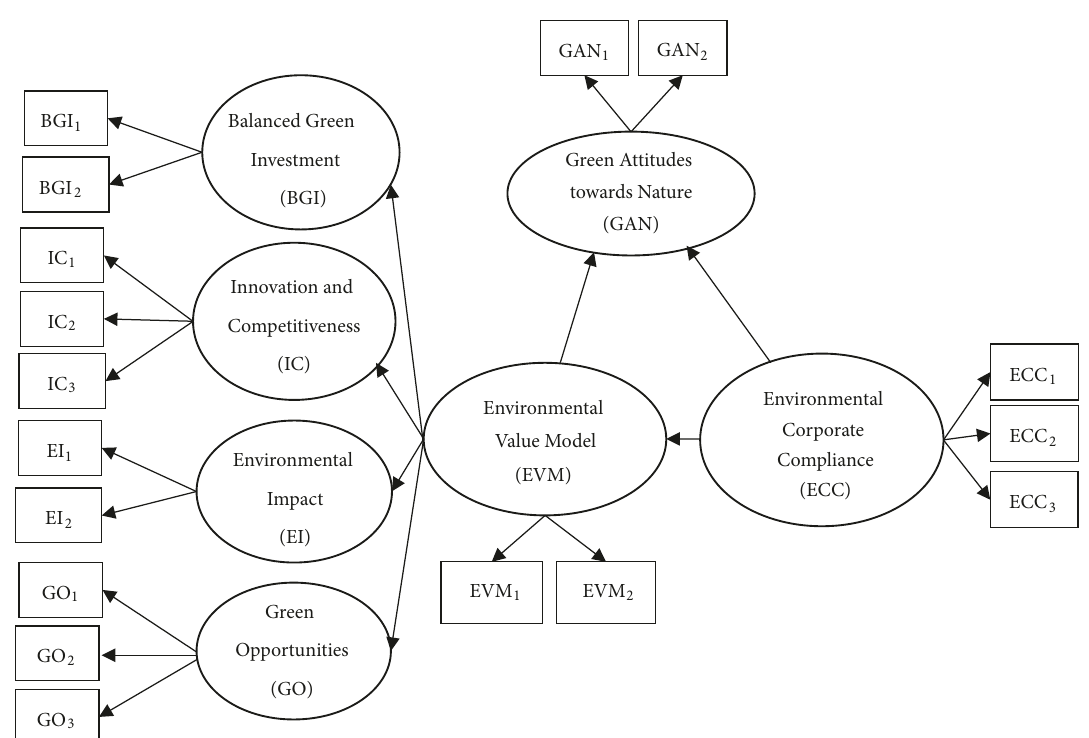
Figure 2: Conceptual scheme of the structural equation model utilized. BAN: Green Attitudes towards Nature. ECC: Environmental Corporate Compliance. EVM: Environmental Value Model. BGI: Balanced Green Investment. EI: environmental impact. IC: innovation and competitiveness. GO: Green Opportunities. EP: Educational